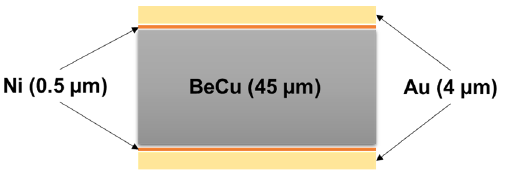
Figure 3. Beryllium-Copper specimen with metal coating.